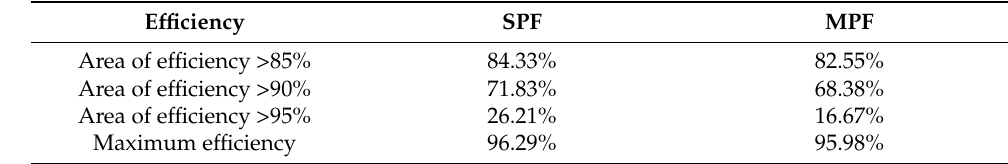
Figure 8. Motor’s efficiency map comparison. Table 3. Comparison of efficiency ratios under two working conditions.